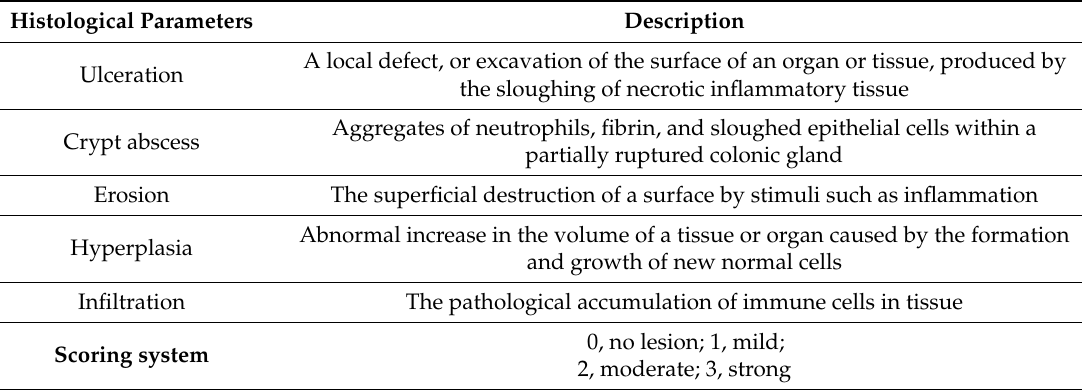
Table 1. Histological parameters for assessment of intestinal